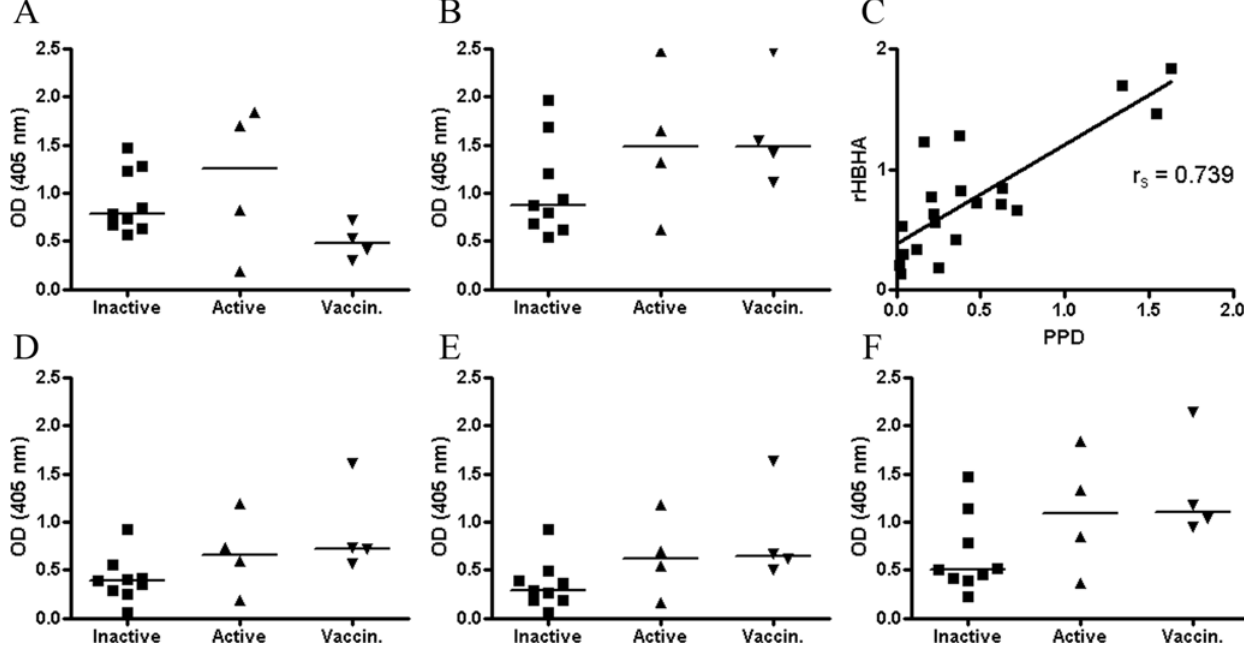
Figure 3. The serological reactivities to synthetic peptides, rMtb-HBHA and PPD were tested in IgG and IgM ELISAs. The groups of patients with inactive TB (n=9), active TB (n=4) and healthy vaccinated individuals (n=4) were enrolled. Serological responses to rMtb-HBHA measured by the IgG EIA (A), IgM EIA (B), and IgG correlation in the PPD and rMtb-HBHA ELISAs (C). IgM responses to methylated 15-mer linear peptides from the C terminus of HBHA: IELPKKAAPA[KMe]KAAP (D), AAPAKKAAPA[KMe]KAAA (E), and AAPAKKAAPA[KMe][KMe]AAA (F). Individual responses are presented as optical densities (OD 405 ). The horizontal bars represent arithmetic median values.